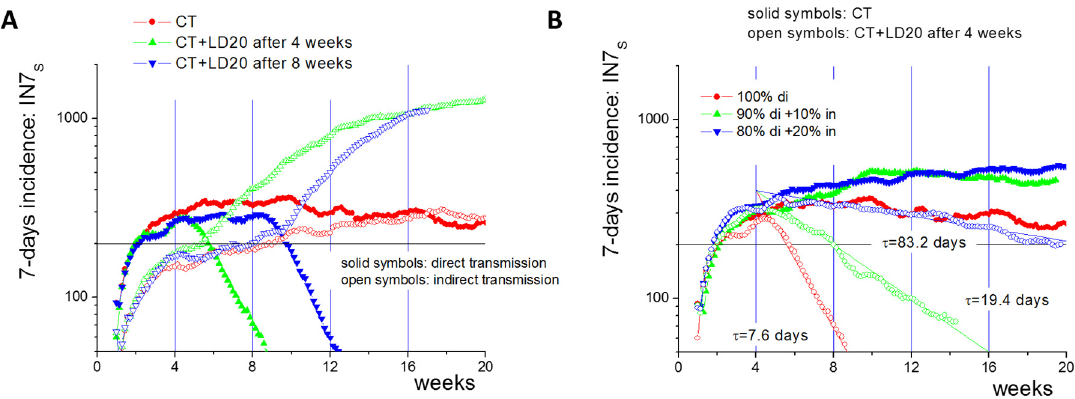
Figure 5. Simulated 7-day incidence IN7 s for different transmission routes (averages over 10 simu- lations). ( A ) In the case of an LD20, the incidence decays exponentially towards 50 within 4 weeks for direct transmission; for indirect transmission it rises to values above 1000. ( B ) A 10% and 20% contribution of indirect transmission increases the plateau level incidence by a factor less than 2. Under LD20, it increases the IN7 s half-life-time by a factor of about 2.5 and 11, respectively. Lines describe an exponential decay from level 400 with half-life-time τ .